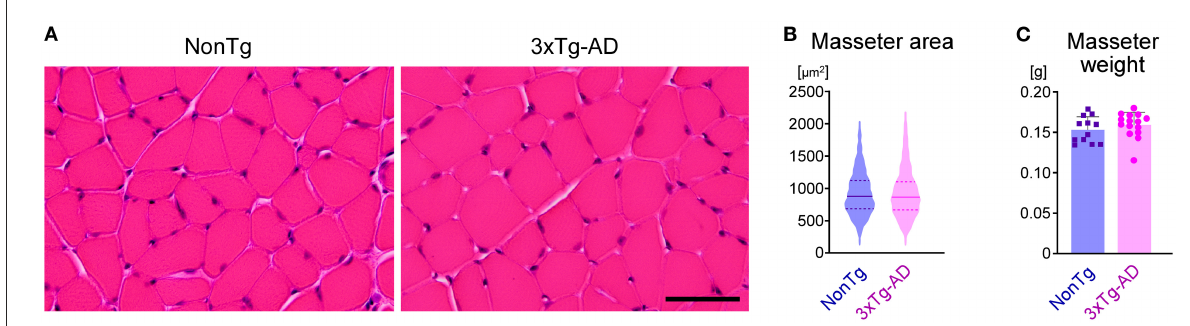
FIGURE7 Morphological comparison of the masseter muscle between 3-month-old NonTg and 3 × Tg-AD mice. (A) Hematoxylin and eosin staining of transverse sections of the masseter muscles in 3-month-old NonTg and 3 × Tg-AD mice. (B) Violin plot depicting the cross-sectional area of muscle fibers of the masseter muscle. The cross-sectional area of 100 muscle fibers from each of six NonTg mice (total 600 muscle fibers) and 100 muscle fibers from each of six 3 × Tg-AD mice (total 600 muscle fibers) was randomly selected and measured. The horizontal solid line and the pair of horizontal dotted lines indicate the mean and the interquartile range, respectively. There were no significant differences between 3-month-old 3 × Tg-AD and NonTg mice in the mean cross-sectional area of muscle fibers of the masseter muscle ( B ; p = 0.9333, two-tailed unpaired t -test) or the mean weight of the masseter muscle ( C ; p = 0.3582, two-tailed unpaired t -test; n = 12, NonTg; n = 14, 3 × Tg-AD). Scale bar: 50 µ m (A)